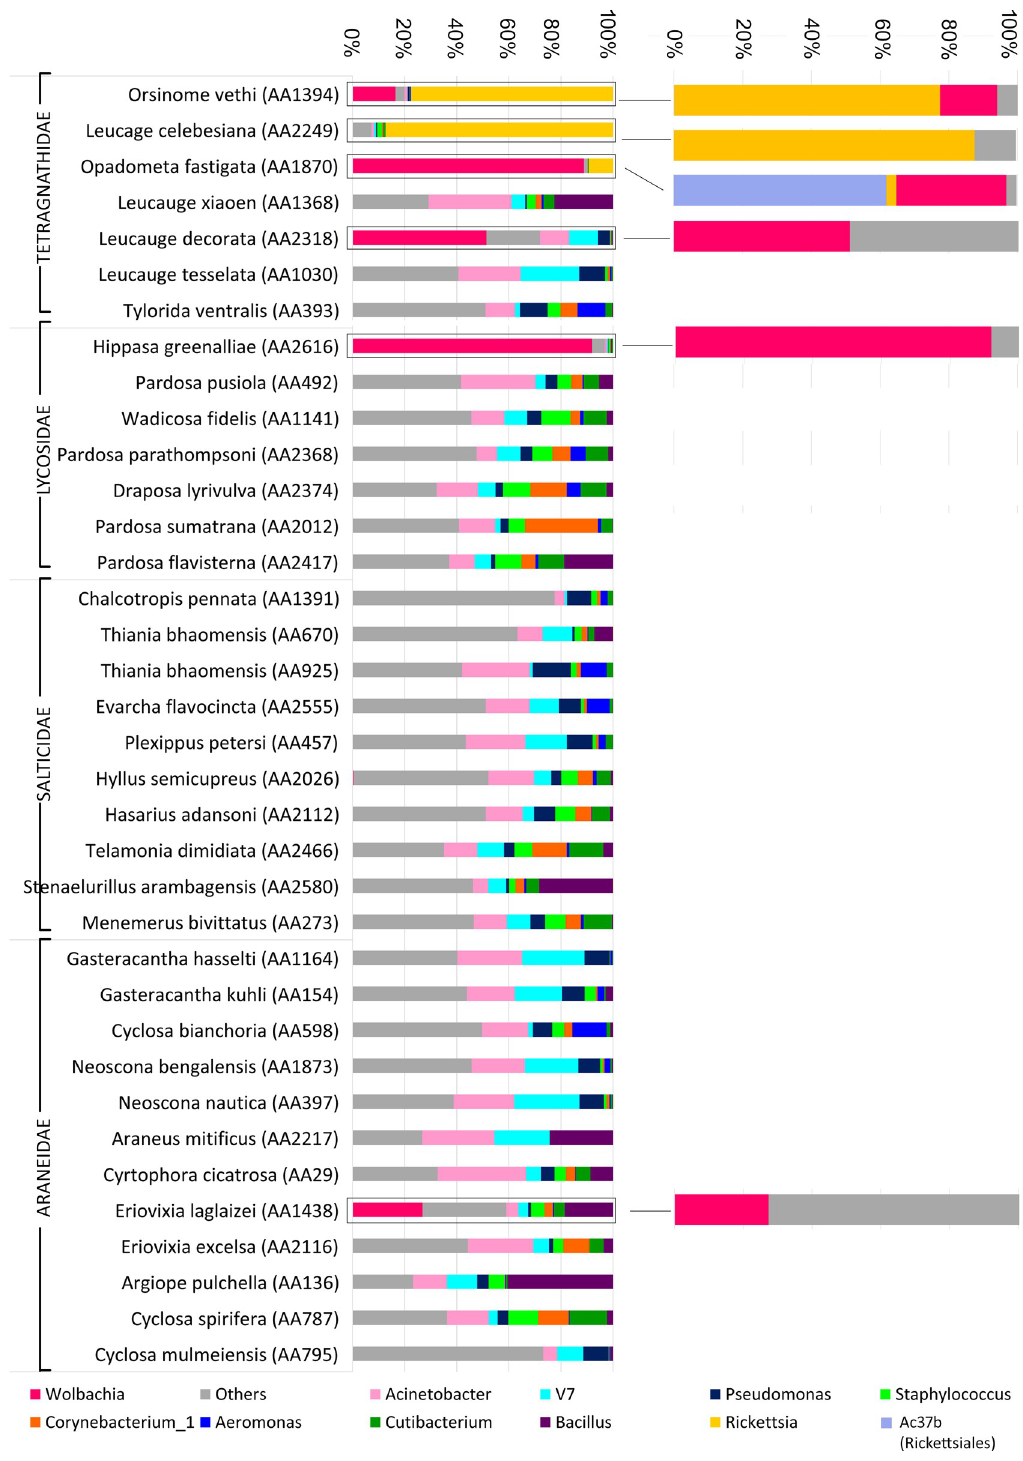
Fig 3. Genus level gut bacterial diversity of spider species along with influence of endosymbiont genera.